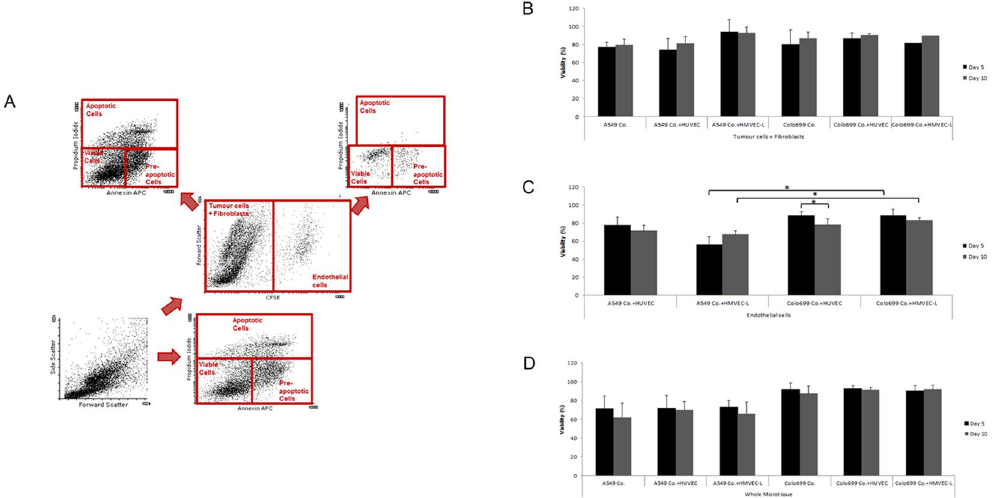
Figure 7. Viability of microtissues: Viability was measured with an Annexin V and Propidium Iodide protocol for flow cytometry. Apoptosis was measured after ten days. Each bar represents the mean cell viability of 18 spheroids and their corresponding standard deviation that was measured in two different runs. Viability in all microtissues was not altered when co-incubated with endothelial cells. Nevertheless, endothelial cells also remained viable throughout the whole incubation period. No difference was observed between the two different endothelial or cancer cell